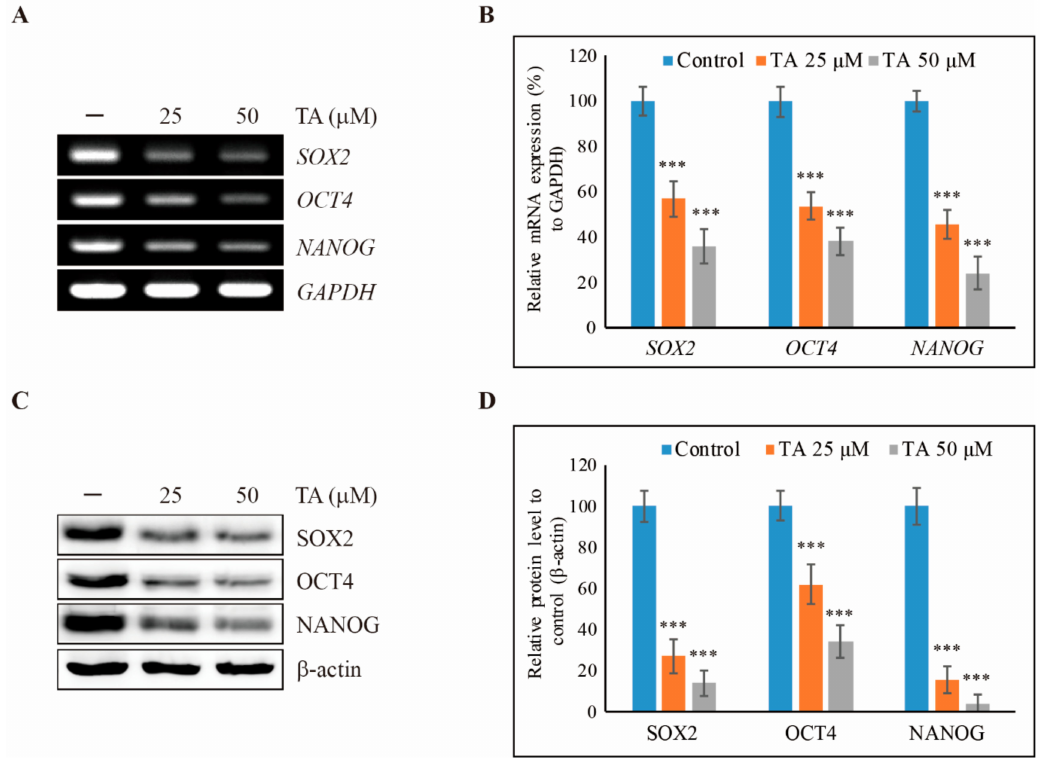
Figure 1. Tannic acid (TA) inhibits cancer stem cell markers in NCCIT cells. ( A ) The expression levels of SOX2 , OCT4 , and NANOG mRNA in the NCCIT cells were detected after TA treatment in concentrations indicated for 48 h. ( B ) The representative expression levels of mRNA were determined by densitometry and normalized to GAPDH mRNA. Controls are set to 100. Data are representative of three independent experiments. *** p < 0.001 ( t -test). ( C ) Western blotting analysis of NCCIT cells with 25 µ M and 50 µ M of TA for 48 h showing the inhibition of cancer stem cell markers SOX2, OCT4, and NANOG expressions. ( D ) The representative expressions of proteins were determined via densitometry and normalized to β -actin. Controls are set to 100. Data are representative of three independent experiments. *** p < 0.001 ( t